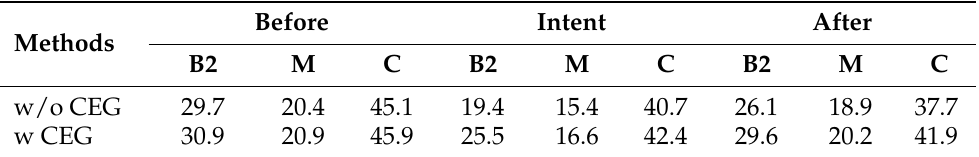
Table 3. Analysis conducted on the validation split of VisualCOMET. We provide an analysis of the behavior of the CEG by observing separate performance evaluations with (w CEG) and without the CEG (w/o CEG).